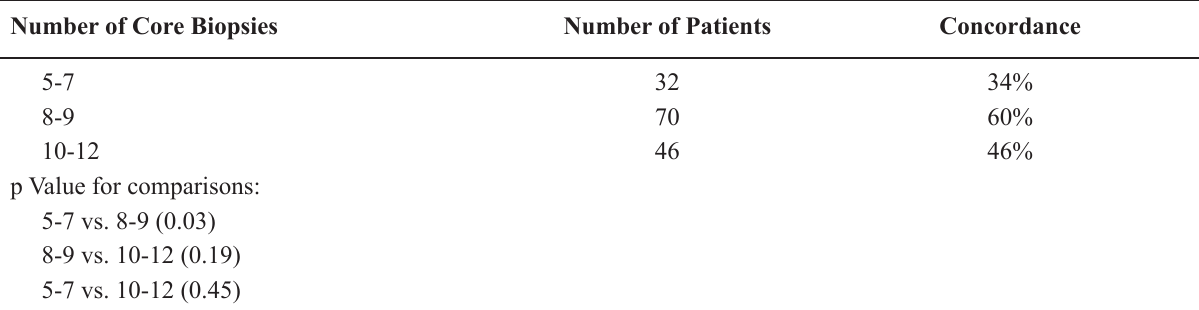
Table 3 – Effect of number of cores on concordance.